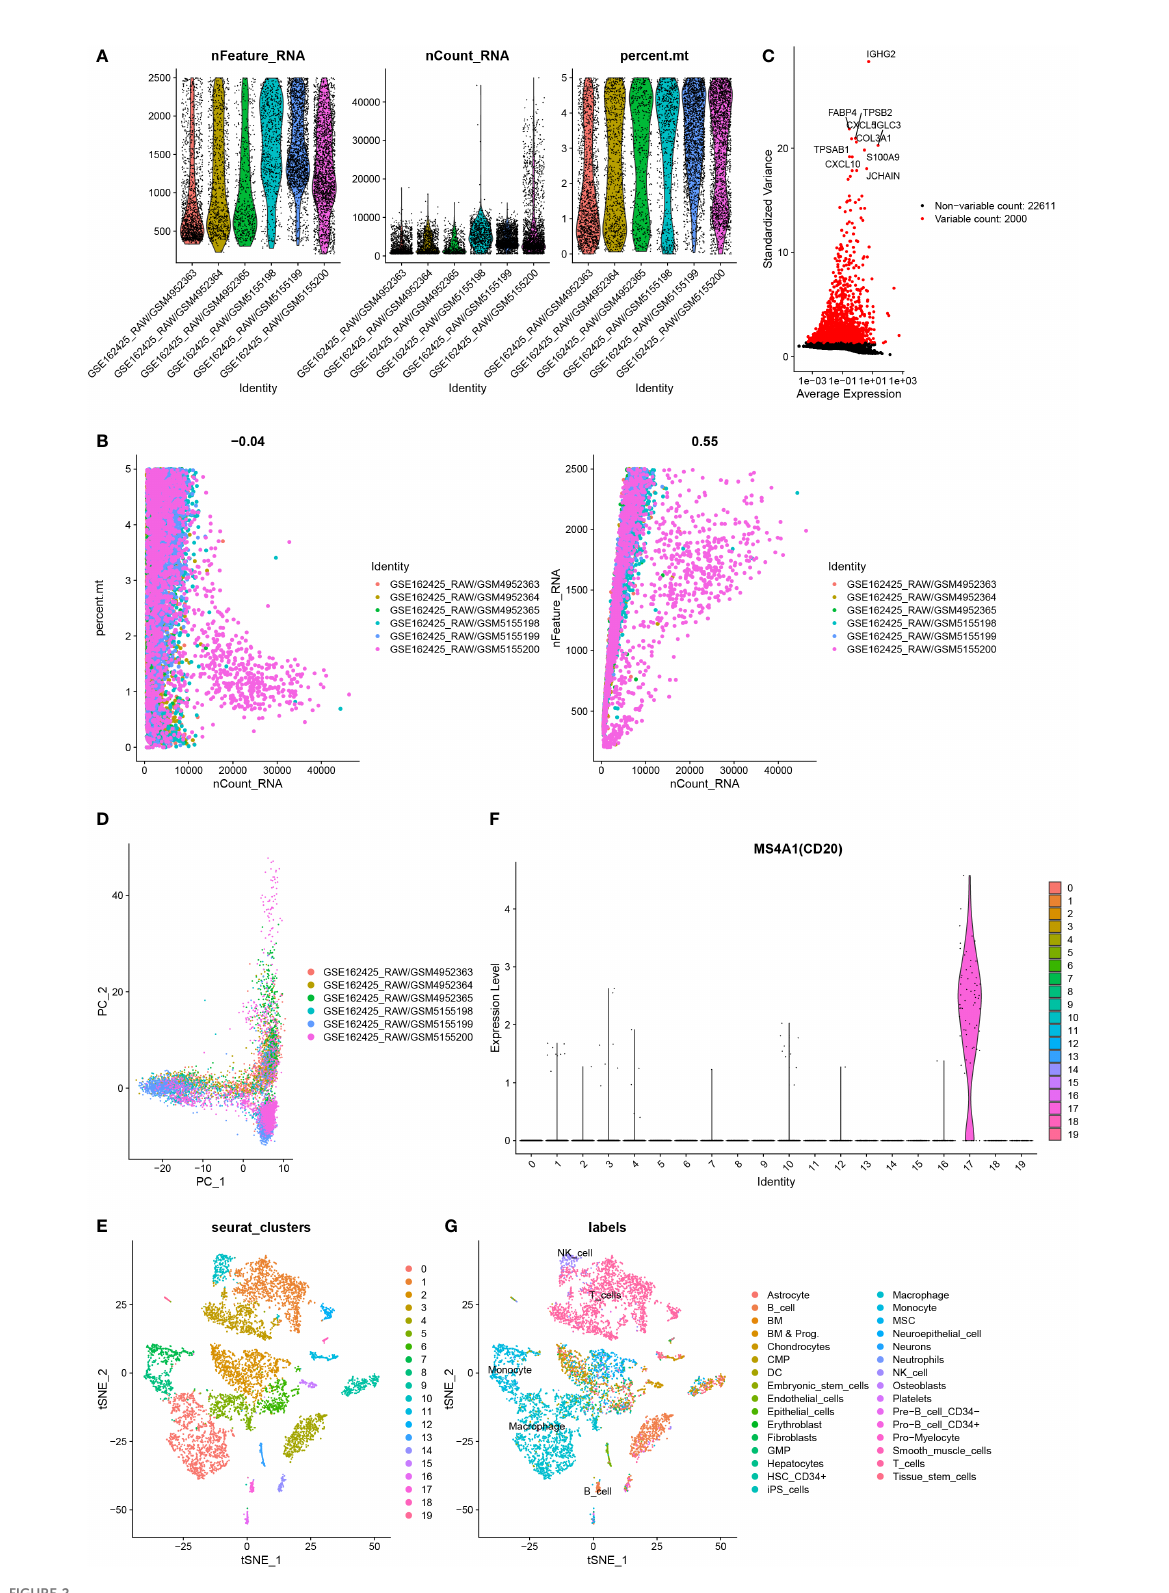
FIGURE 2 Identi fi cation of B cell marker genes by single-cell sequencing samples. (A) The violin map shows the gene count of each cell, the sum of all gene expression levels in each cell, and the percentage of mitochondrial genes. (B) A scatter plot of the percentage of mitochondrial genes and gene counts in the sum of all gene expression levels in each cell. (C) Detection of highly variable genes across the cells. The X-axis represents the average expression, and the y-axis represents standardized variance. (D) PCA plot colored by 6 samples. (E) t-SNE plot colored by various cell types. (F) violin plot of MS4A1 in t-SNE. (G) The cell types are identi fi ed by marker